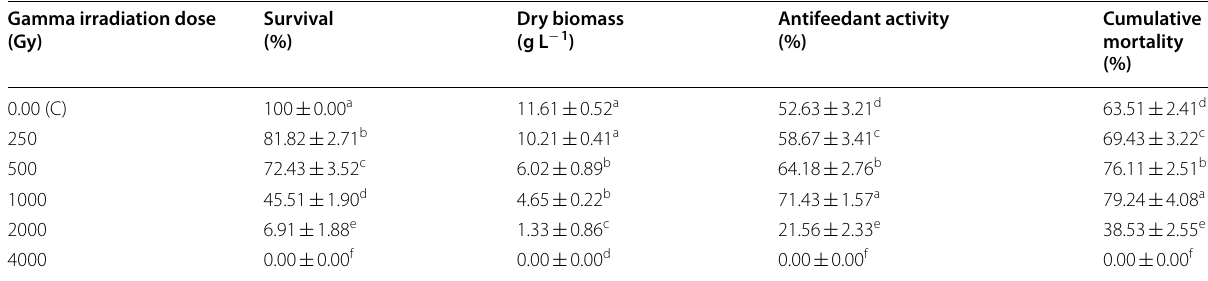
Table 4 Effect of different doses of gamma irradiation on survival (%), dry biomass (g L − 1 ), antifeedant activity (%), and cumulative mortality (%) of the 3rd instar Spodoptera littoralis larvae feeding on castor leaves treated with methylene chloride extract of